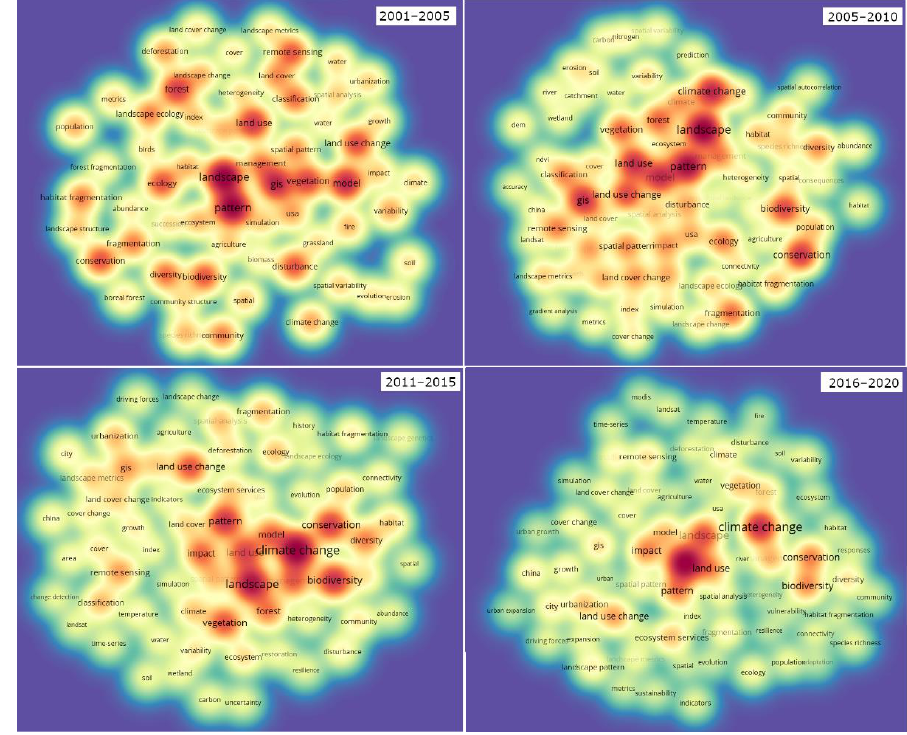
Figure 6. Density map. Obtained with VOSviewer.